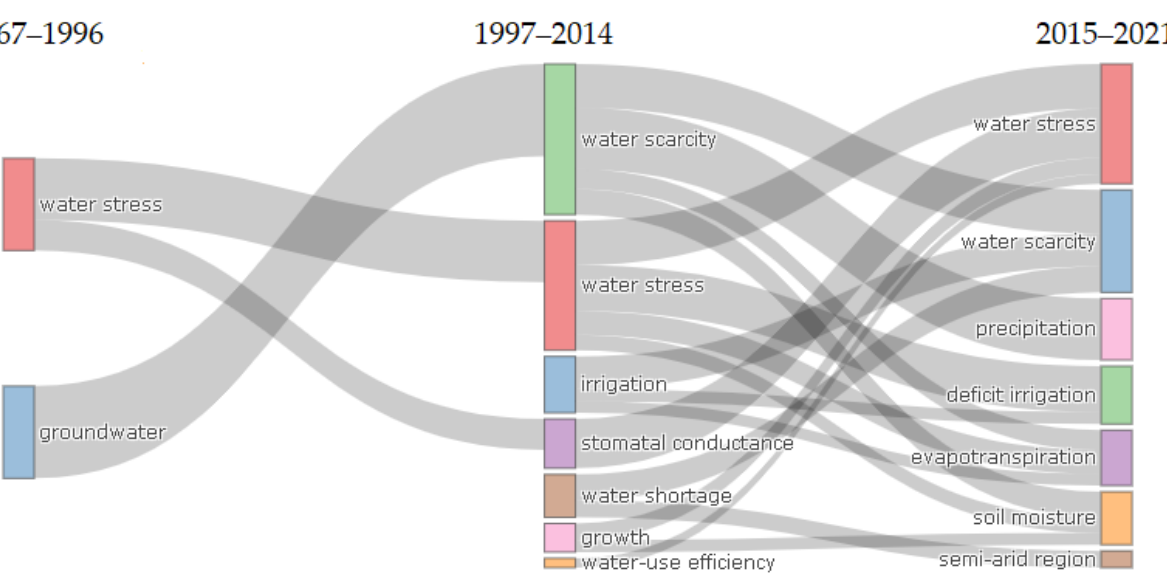
Figure 6. Sankey diagram showing the thematic evolution of water scarcity in semi-arid zones.